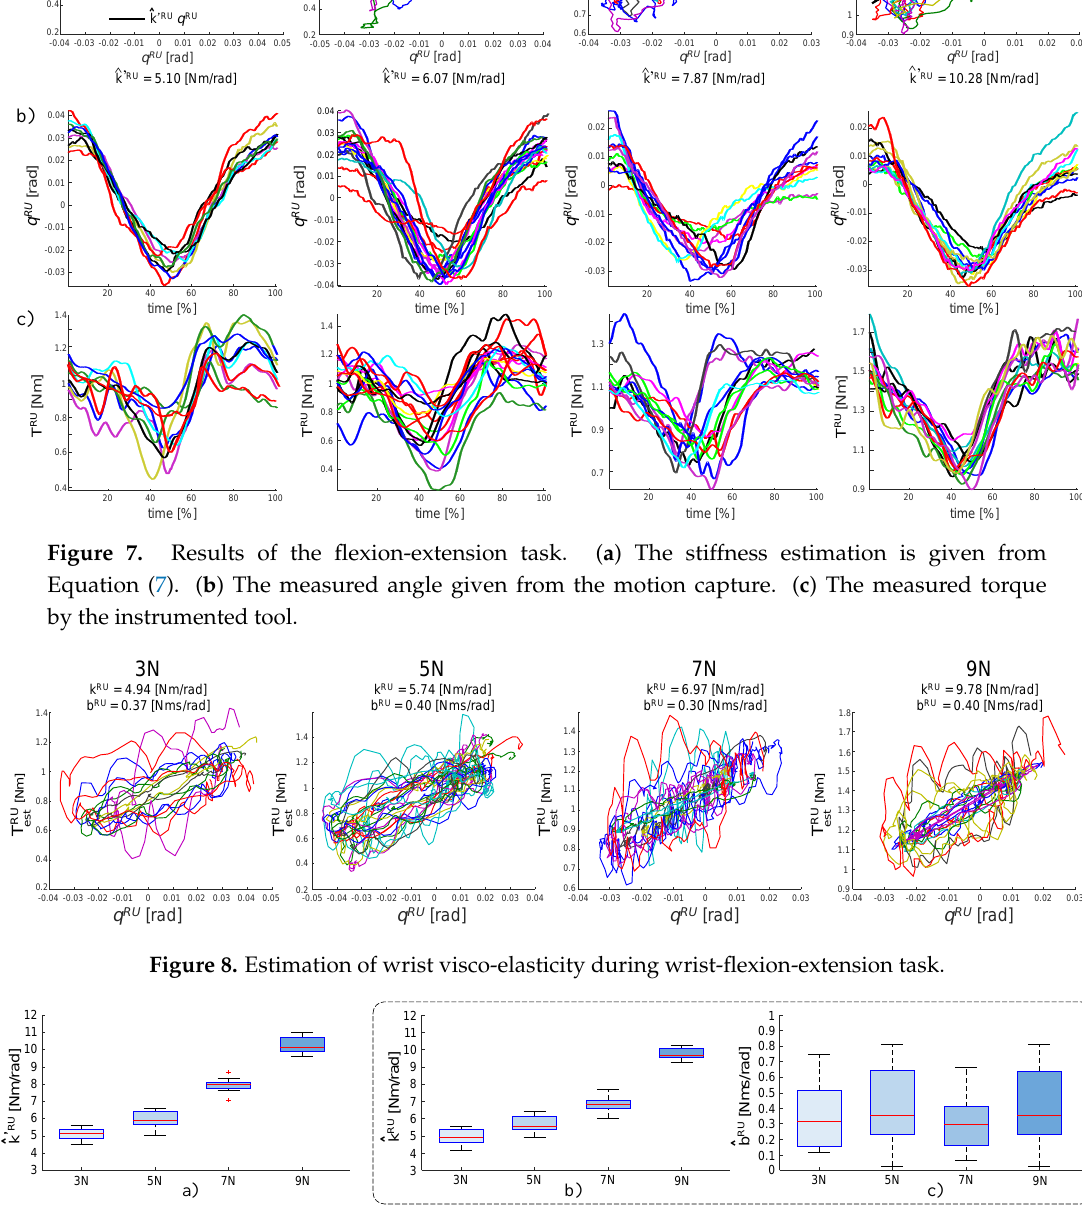
Figure 9. Results of the stiffness estimation for the radio-ulnar deviation. Stiffness distribution for four levels of applied forces: 3N, 5N, 7N, and 9N, respectively. ( a ) Estimated scalar stiffness (cid:98) k (cid:48) RU from Equation (7) . ( b , c ) Estimated scalar stiffness (cid:98) k RU and damping (cid:98) b RU from Equation